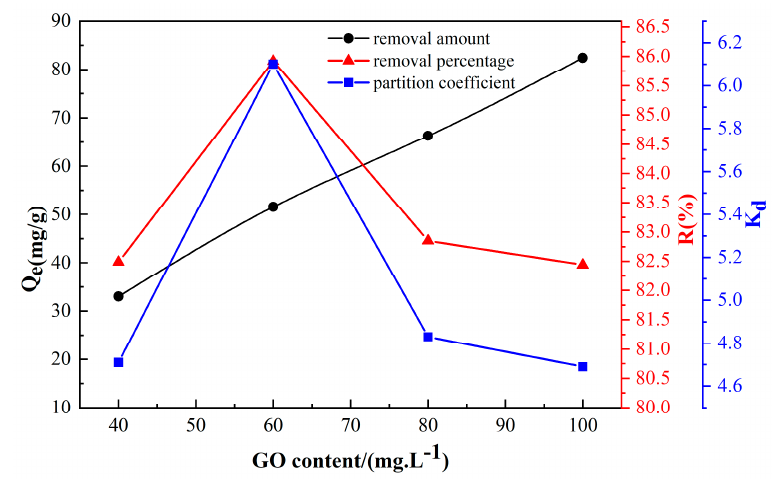
Figure 9. Effects of GO content on the adsorption of GO by iron tailings.